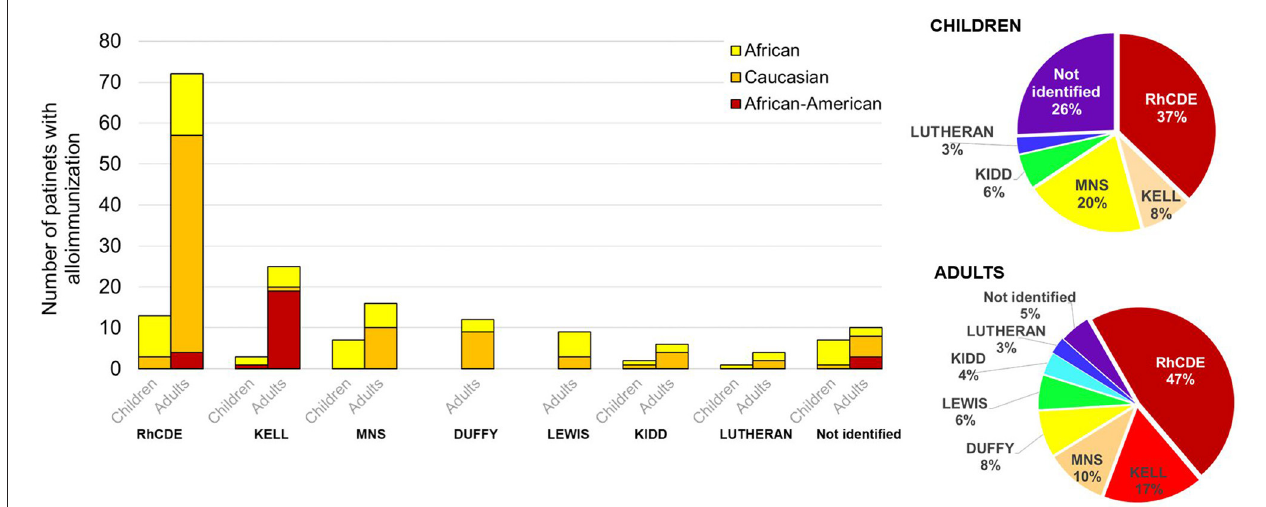
FIGURE 3 | Number of children/adults in SCD patients by antibody system. The pie charts report the overall distribution of the specific antibodies for children and adults. Data are shown as column chart that reports, for each system and differentiating for children/adults, the number of African, Caucasian and African-American patients with the specific